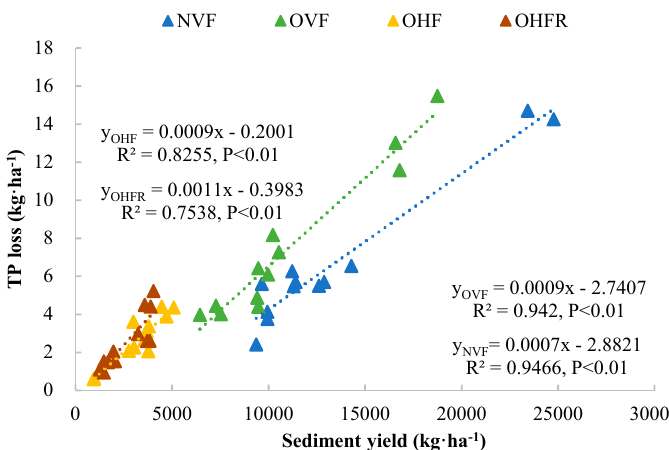
Figure 7. Linear regressions of annual TP losses and sediment